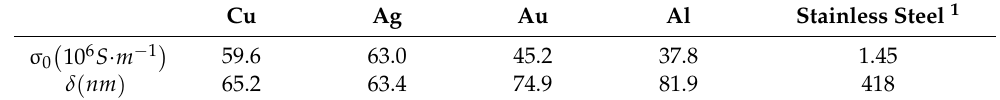
Table 1. Properties of most used metals in terms of conductivity ( σ 0 ) and skin depth ( δ ) at 1 THz. Cu Ag Au Al Stainless Steel 1